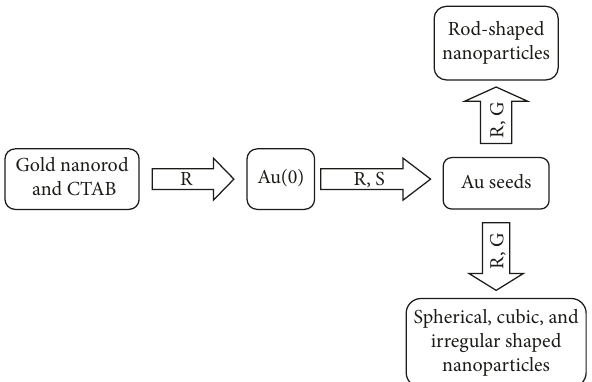
Figure 7: Illustration of the template method to synthesize gold nanorods and reduction of Au(I). S, forming Au seeds; G, growth of the Au seeds